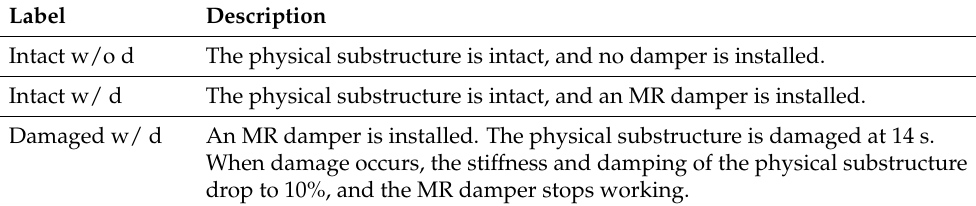
Figure 9. Third-floor displacement responses of Intact w/ d and Damaged w/ d (El Centro earth- quake, Case 4).